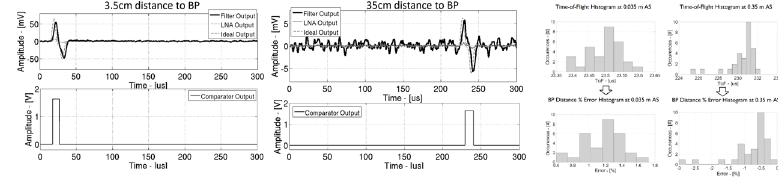
Figure 1. Left: Typical ionoacoustic setup. Right: Acoustic wave simulated by cross-domain model .